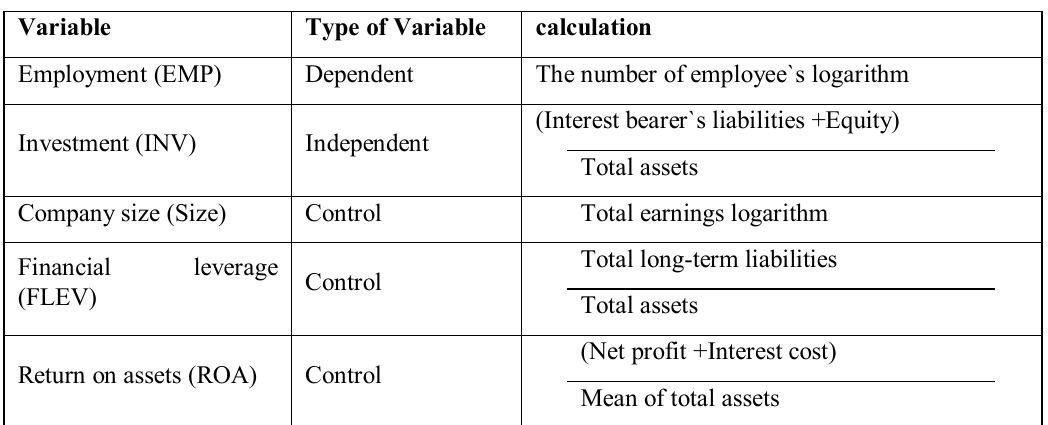
Table 1: Research